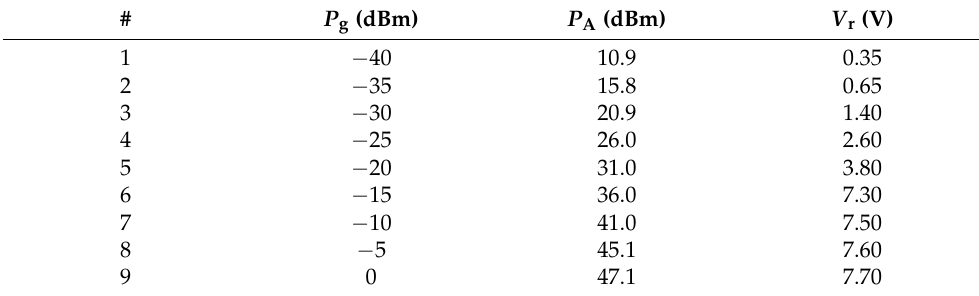
Table 4. Measured input power and the corresponding rectifier voltage.